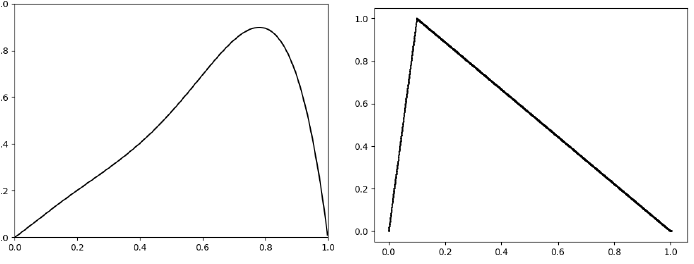
Figure 14. The graph of the function g 2 ( left ) and a fuzzy set A represented by 2020 equidistantly distributed points ( right ).